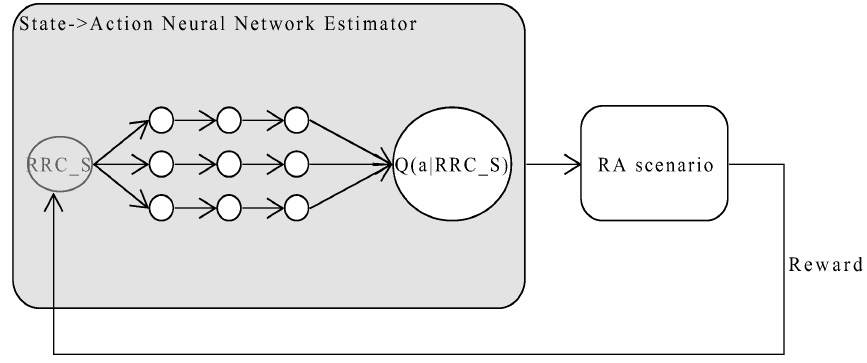
Figure 4. The Deep Q -Network (DQN)-based agent interacts with the random access network environment to receive